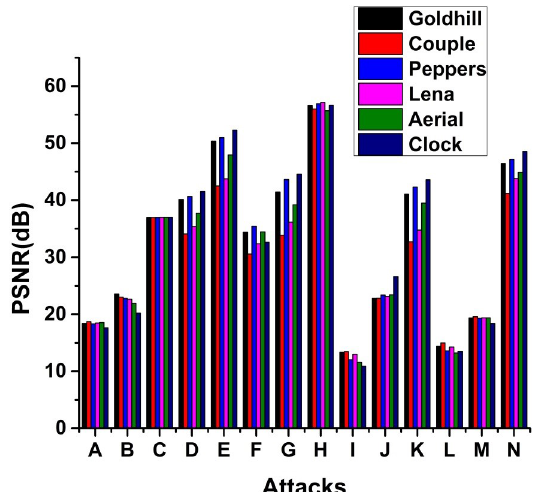
Figure 6: Imperceptibility Analysis for Proposed Scheme under Several Attacks (A) Salt & pepper Noise (0.05) (B) Speckle Noise (0.02) (C) Gaussian Noise (0, 0.0002) (D) Sharpening (E) Gaussian Filter (3 × 3) (F) Average Filter (3 × 3) (G) Median Filter (3 × 3) (H) JPEG Compression (100) (I) Rotation (3 ∘ ) (J) Gamma Correction (0.8) (K) Scaling (0.5, 2) (L) Translation [10 10] + Salt & pepper Noise (0.001) (M) JPEG Compression (60) + Salt & pepper Noise (0.04) (N) JPEG Compression (80) + Scaling (2,0.5).